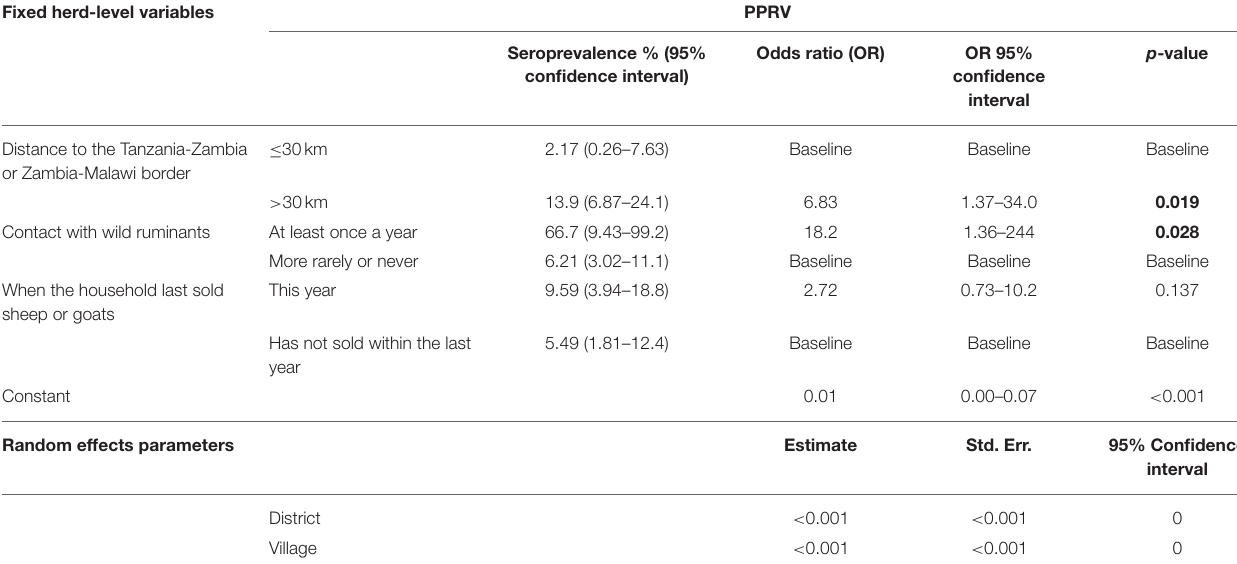
TABLE 9 | Predictor variables associated with herd-level seropositivity for PPRV.